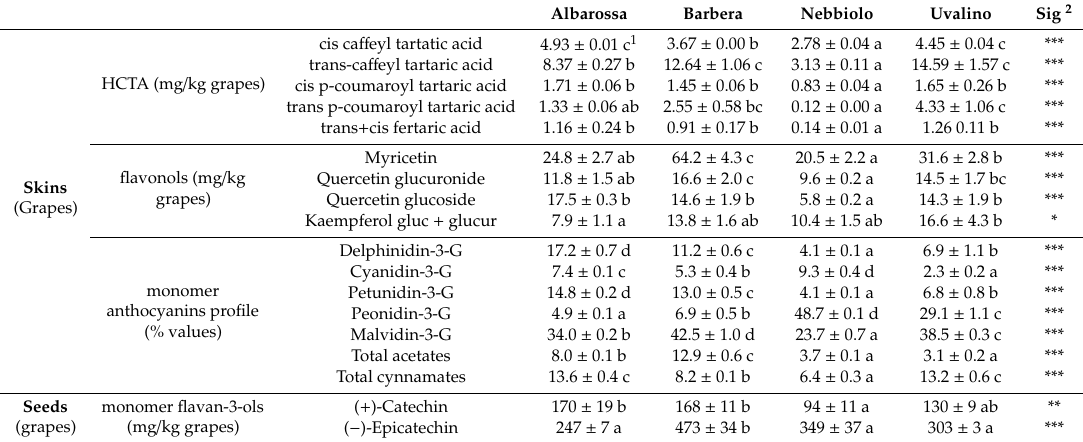
Table 3. Hydroxycinnamiltartaric acids, flavonols content, and anthocyanins profile of the grape skin extracts. Content of ( + )-catechin and ( − )-epicatechin in the seed extracts. Standard deviations and ANOVA results.